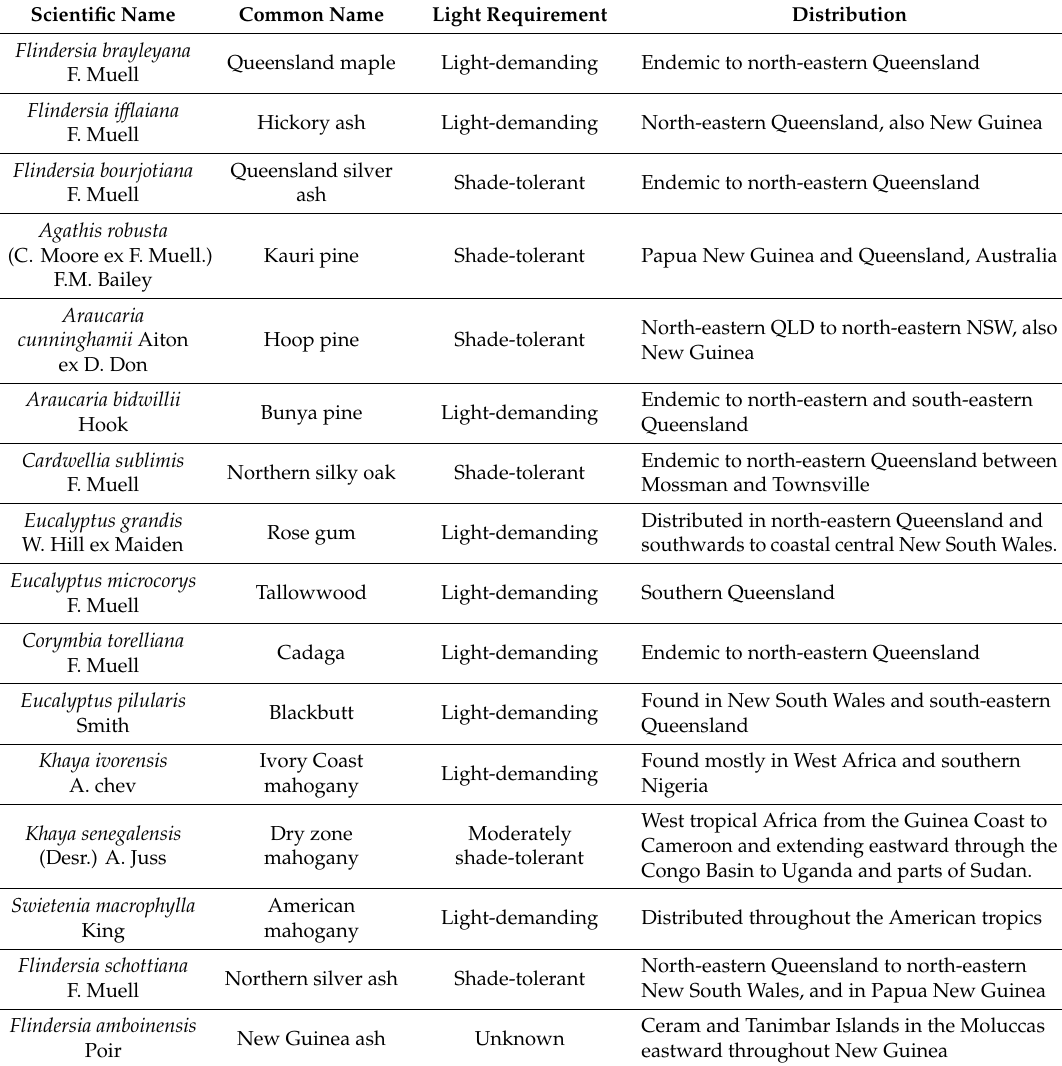
Table 1. Some characteristics of the tree species used in enrichment planting experiments in north